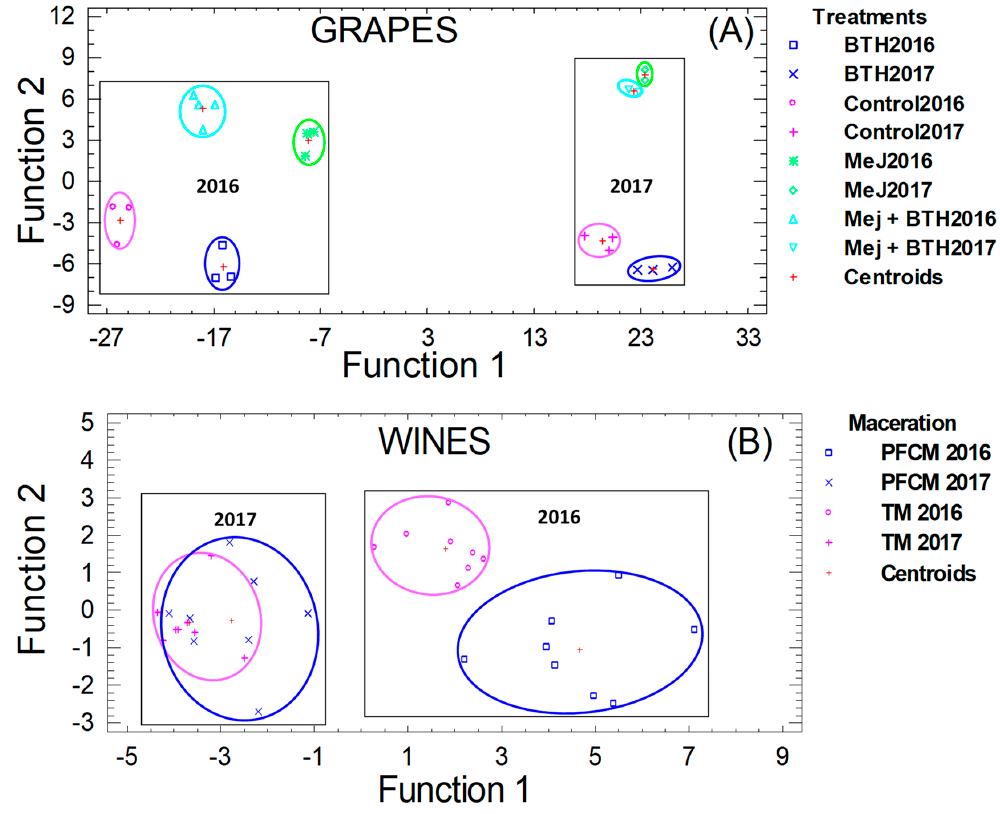
Figure 4. Distribution of the grapes ( A ) and wines ( B ) samples, in the coordinate system defined by the discriminants functions, used to di ff erentiate among the treatments.